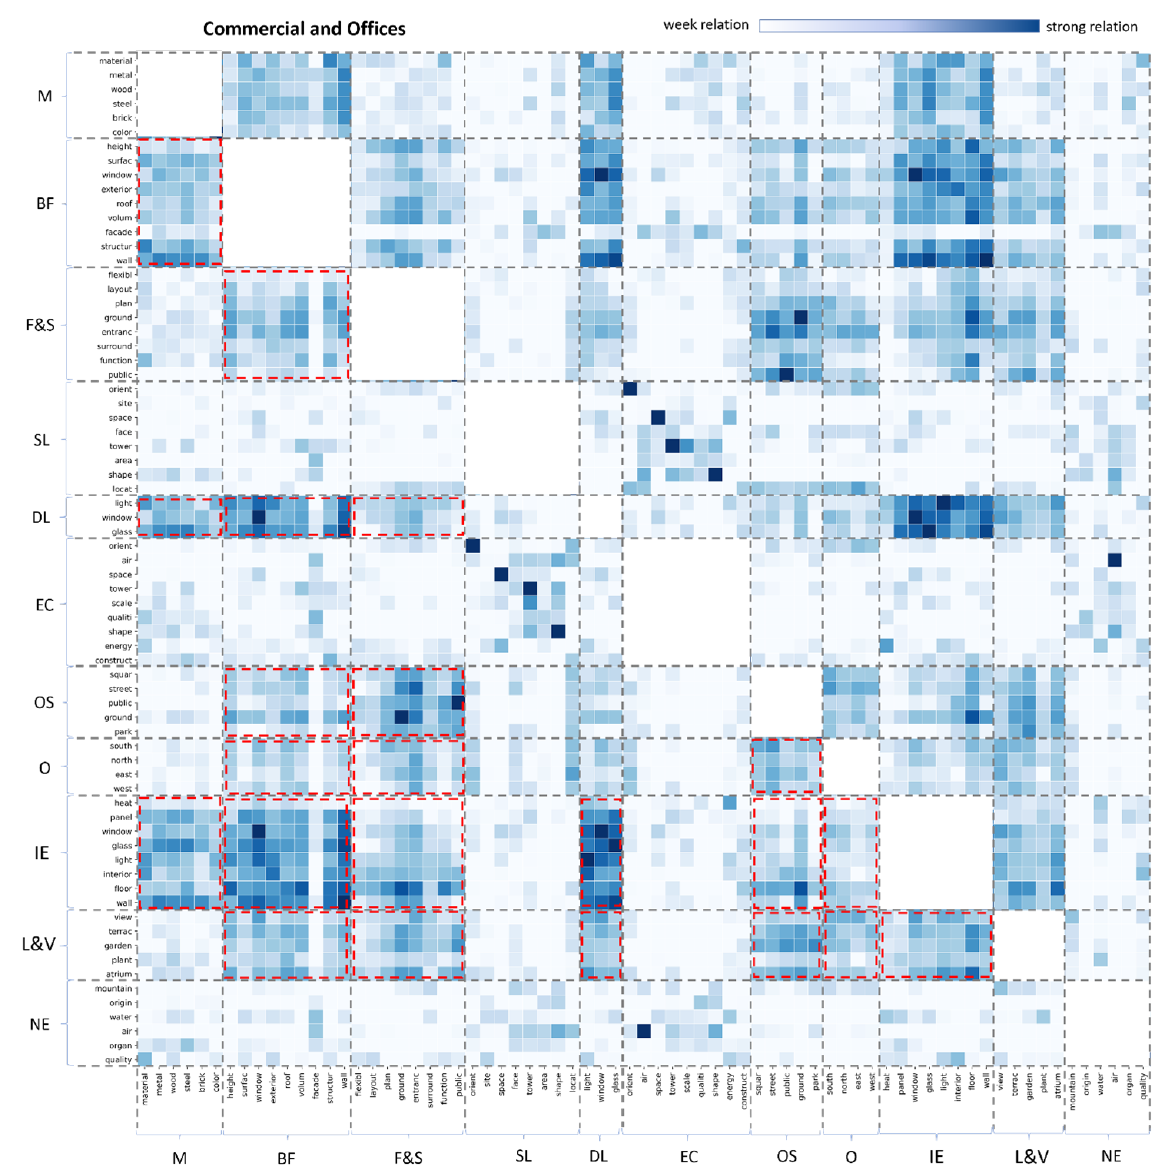
Figure 10. Heat map of clustered words related to commercial and